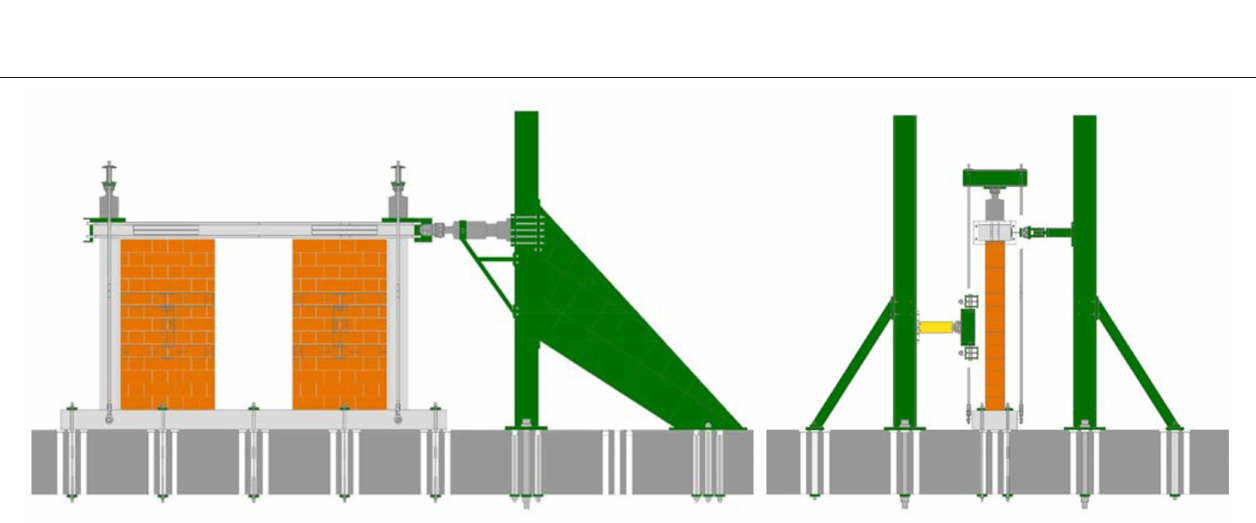
Frontiers in Built Environment |